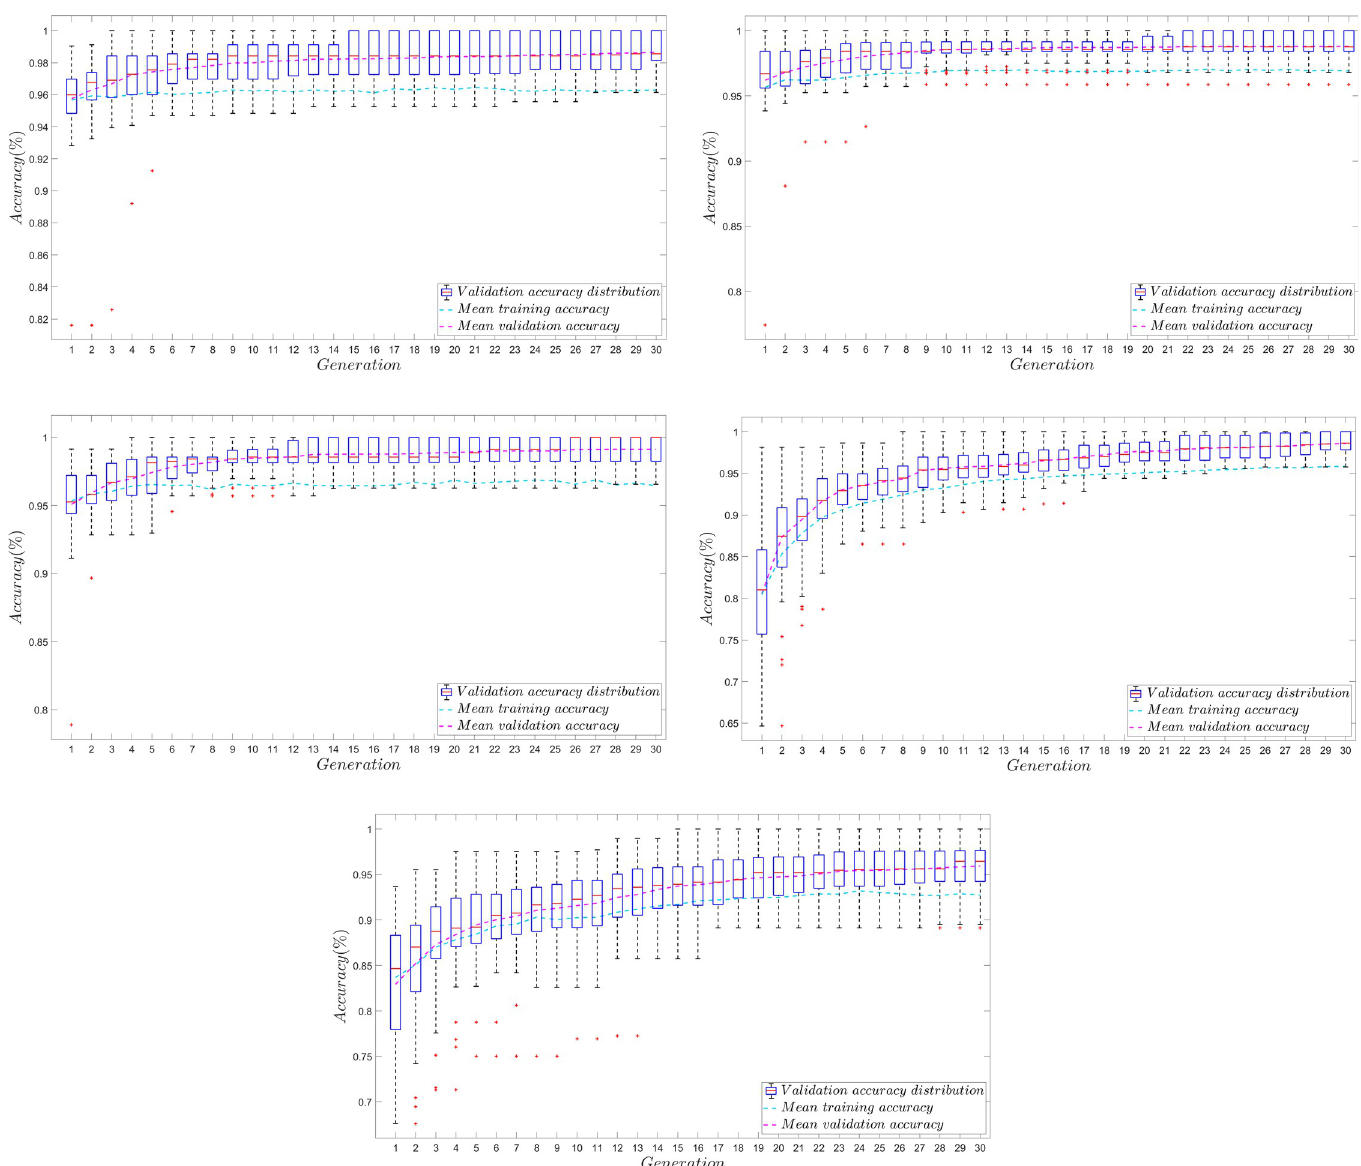
Fig 7. Average performance accuracy of NN models per generation. The plots show the average accuracy of each NN model during the GA-based NN hyperparameter tuning process. The averaged metric shown for each generation is derived from the metric of the best individual over 50 trials. Evident in the GA plots, the FNN models were the fastest to achieve steady-state performance while the RNN model was the slowest. The RNN plot also shows a comparatively larger range of values per generation, which may suggest that the search space for RNN models of very high accuracy is relatively smaller than those of the FNNs and the CNN; hence RNN models may be the most difficult to tune. A. Average performance accuracy of FNN2-type individuals per generation. B. Average performance accuracy of FNN4-type individuals per generation. C. Average performance accuracy of FNN8-type individuals per generation. D. Average performance accuracy of CNN-type individuals per generation. E. Average performance accuracy of RNN-type individuals per